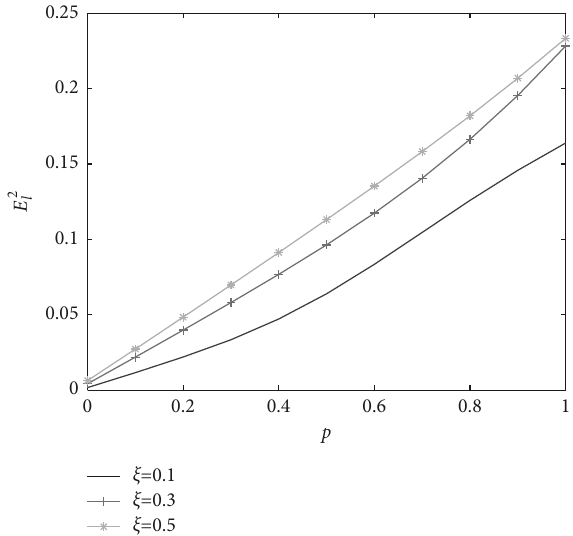
Figure 5: Effect of p on mean number of lost customers due to server’s vacation E 2 l for various impatient rate ξ q for various